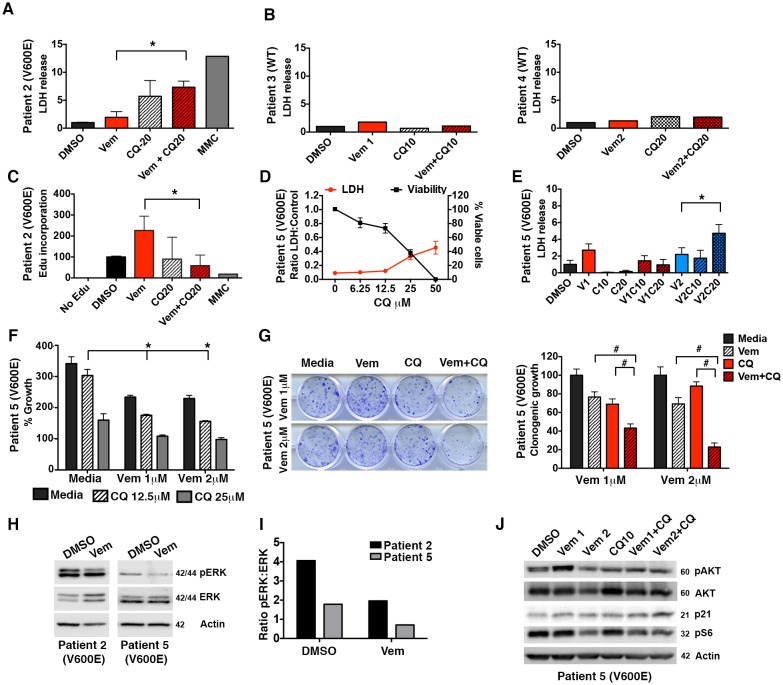
Autophagy inhibition is effective in a variety of BRAFV600E tumor models.(A) Slice culture evaluation showing cytotoxicity as measured by LDH release in Patient #2 V600E mutant tumor. (B) No significant cytotoxicity as measured by LDH release is seen in Patients #3 and #4 with wild type (WT) BRAF tumors. (C) Decrease in EdU incorporation in Patient #2 V600E mutant tumor with combination BRAF (Vem) and autophagy (CQ) inhibition. (D) Cell line derived from Patient #5 with V600E mutant tumor showing retained response to pharmacologic inhibition of autophagy with decreasing viability and contrasting increase in LDH release with increasing doses of CQ. (E) LDH release in Patient #5 V600E mutant tumor cells treated with vemurafenib (Vem) at 1 or 2 μM, CQ at 10 or 20 μM autophagy inhibition (CQ), BRAFi (Vem), or combination therapy for 72 hr as indicated. Unpaired two-tailed Student’s t-test; mean ± s.e.m, n = 3. *p<0.05. (F) Short-term (five day) growth assay demonstrating percent growth of Patient #5 cell line following autophagy inhibition (CQ), BRAFi (Vem), or combination therapy. (G) Representative long-term (fourteen day) clonogenic assay and quantified collated data for cells treated with combination drug therapy as indicated; Vem at 1 or 2 μM, CQ at 10 μM; Unpaired two-tailed Student’s t-test; mean ± s.e.m. # p<0.001, n = 3. (H) Representative Western blot and (I) quantification demonstrating pERK response in resistant primary patient samples following BRAFi (Vem). (J) Western blot of PTEN downstream effectors in Patient #5 V600E mutant tumor cells, known to carry a PTEN mutation. No significant protein changes with BRAFi (Vem), autophagy inhibition (CQ), or combination therapy.DOI:
http://dx.doi.org/10.7554/eLife.19671.01710.7554/eLife.19671.018Figure 7—source data 1.Western quantifications, LDH and survival data.(A) Normalized LDH release of Patient #2 slice culture samples. (C) EdU quantification by flow cytometry of slice culture samples. (D) LDH and cell viability of Patient #5 cell line treated with increasing doses of CQ. (E) Normalized LDH release of Patient #5 cell line treated with vemurafenib, CQ, or a combination of the two drugs. (G) Quantification of long-term clonogenic growth assays in Patient #5 cell line treated with vemurafenib, CQ, or a combination of the two drugs.